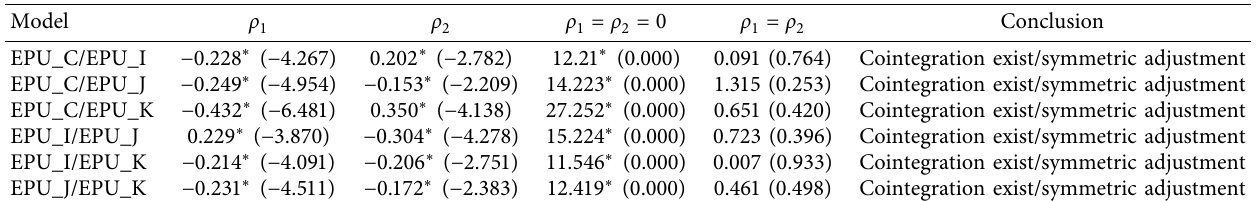
Table 6: Enders-Siklos cointegration test results according to the TAR model.